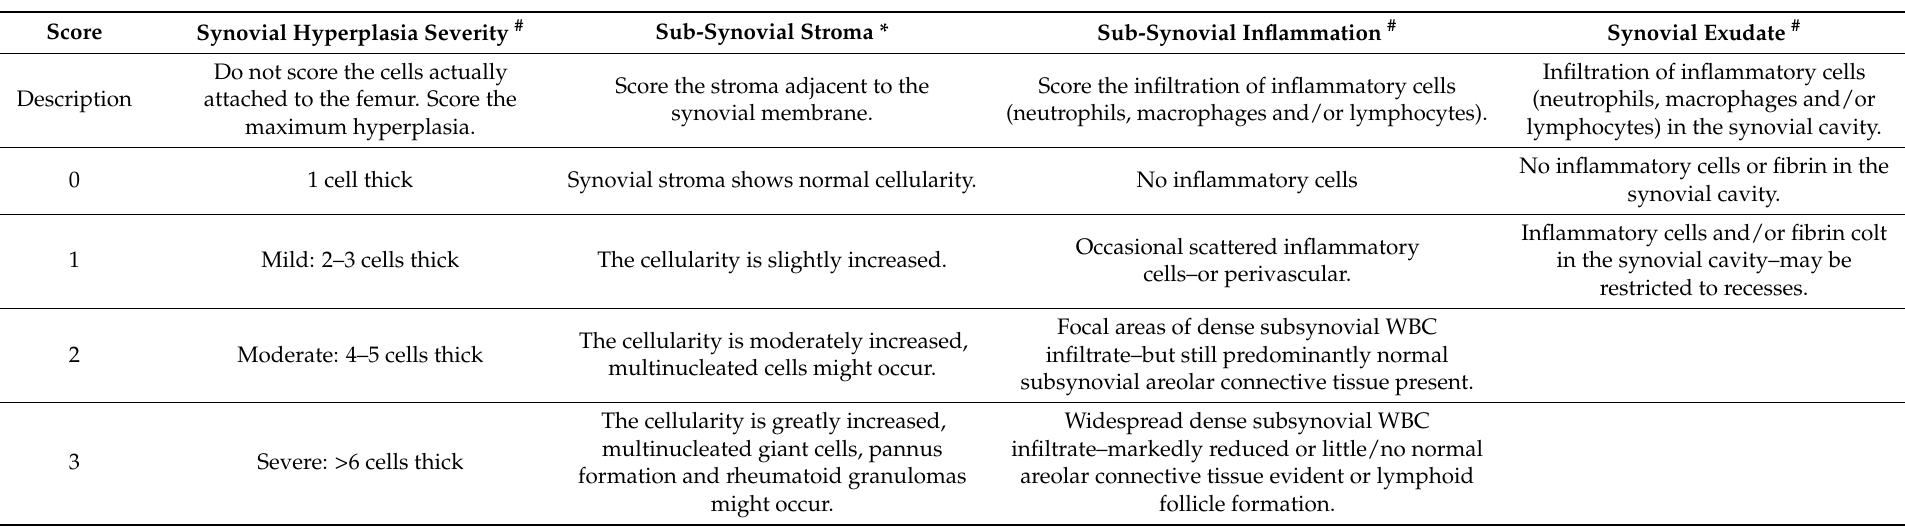
Table A1. Synovitis Scoring Parameters. Parameters assessed are adapted from # Jackson et al., 2014 [22] and * Krenn et al., 2006